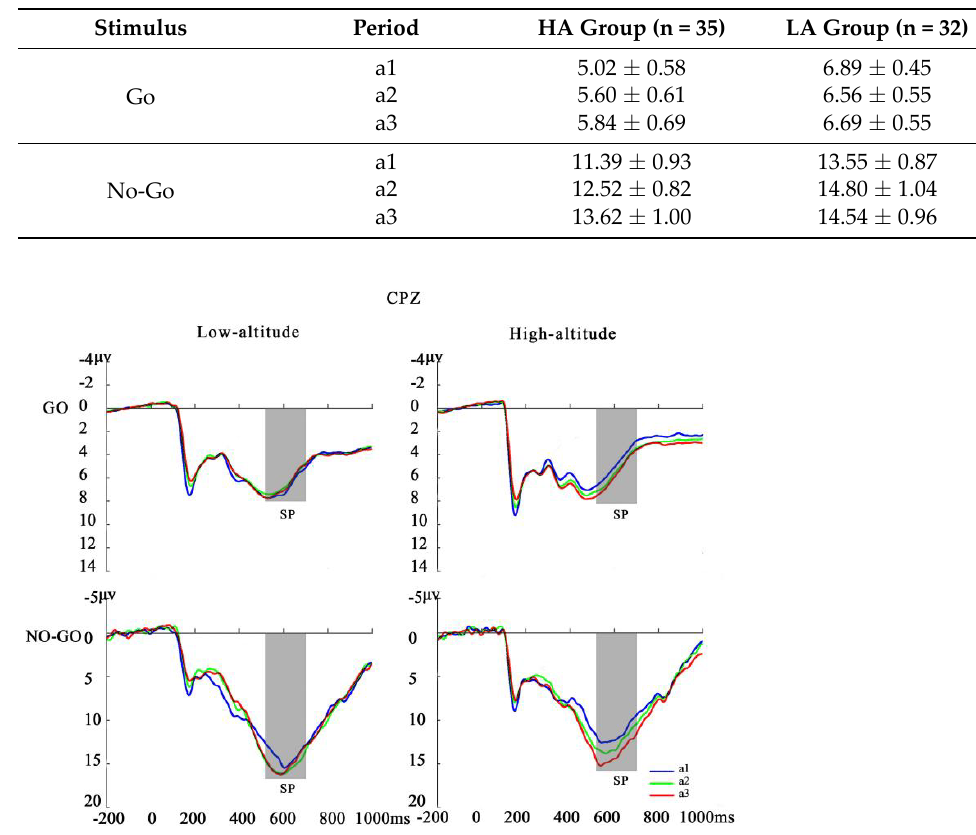
Figure 4. The images represent activity on the scalp at the time corresponding to the maximum amplitude of each component for each group. 3.4. Time-Frequency Analysis 3.4.1. Theta The ANOVA testing performed on the theta power results revealed a significant interaction between altitude and period ( F (2, 64) = 5.17, p < 0.01, 𝜂𝜂 𝑠𝑠2 = 0.139). Comparisons indicated that the theta power of HAs was significantly higher than LAs at periods a2 (HA: 0.52 ± 0.11, LA: 0.24 ± 0.08; p < 0.05) and a3 (HA: 0.78 ± 0.16; LA: 0.22 ± 0.09; p < 0.01). In HAs, theta power increased significantly between periods a1 and a3 (a1: 0.42 ± 0.09; a3: 0.78 ± 0.16; p < 0.05), while remaining stable with time spent on task in LAs (Table 6 and Figure 5).